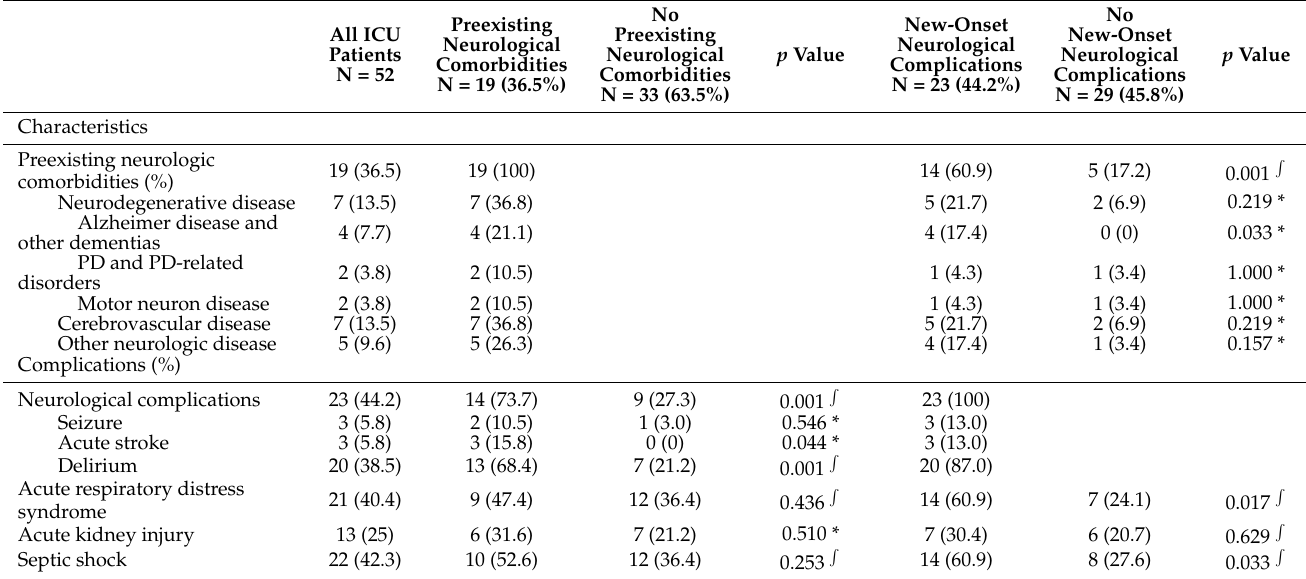
Table 2. Preexisting neurological comorbidities and new-onset neurological complications of 52 intensive care unit patients infected with COVID-19.